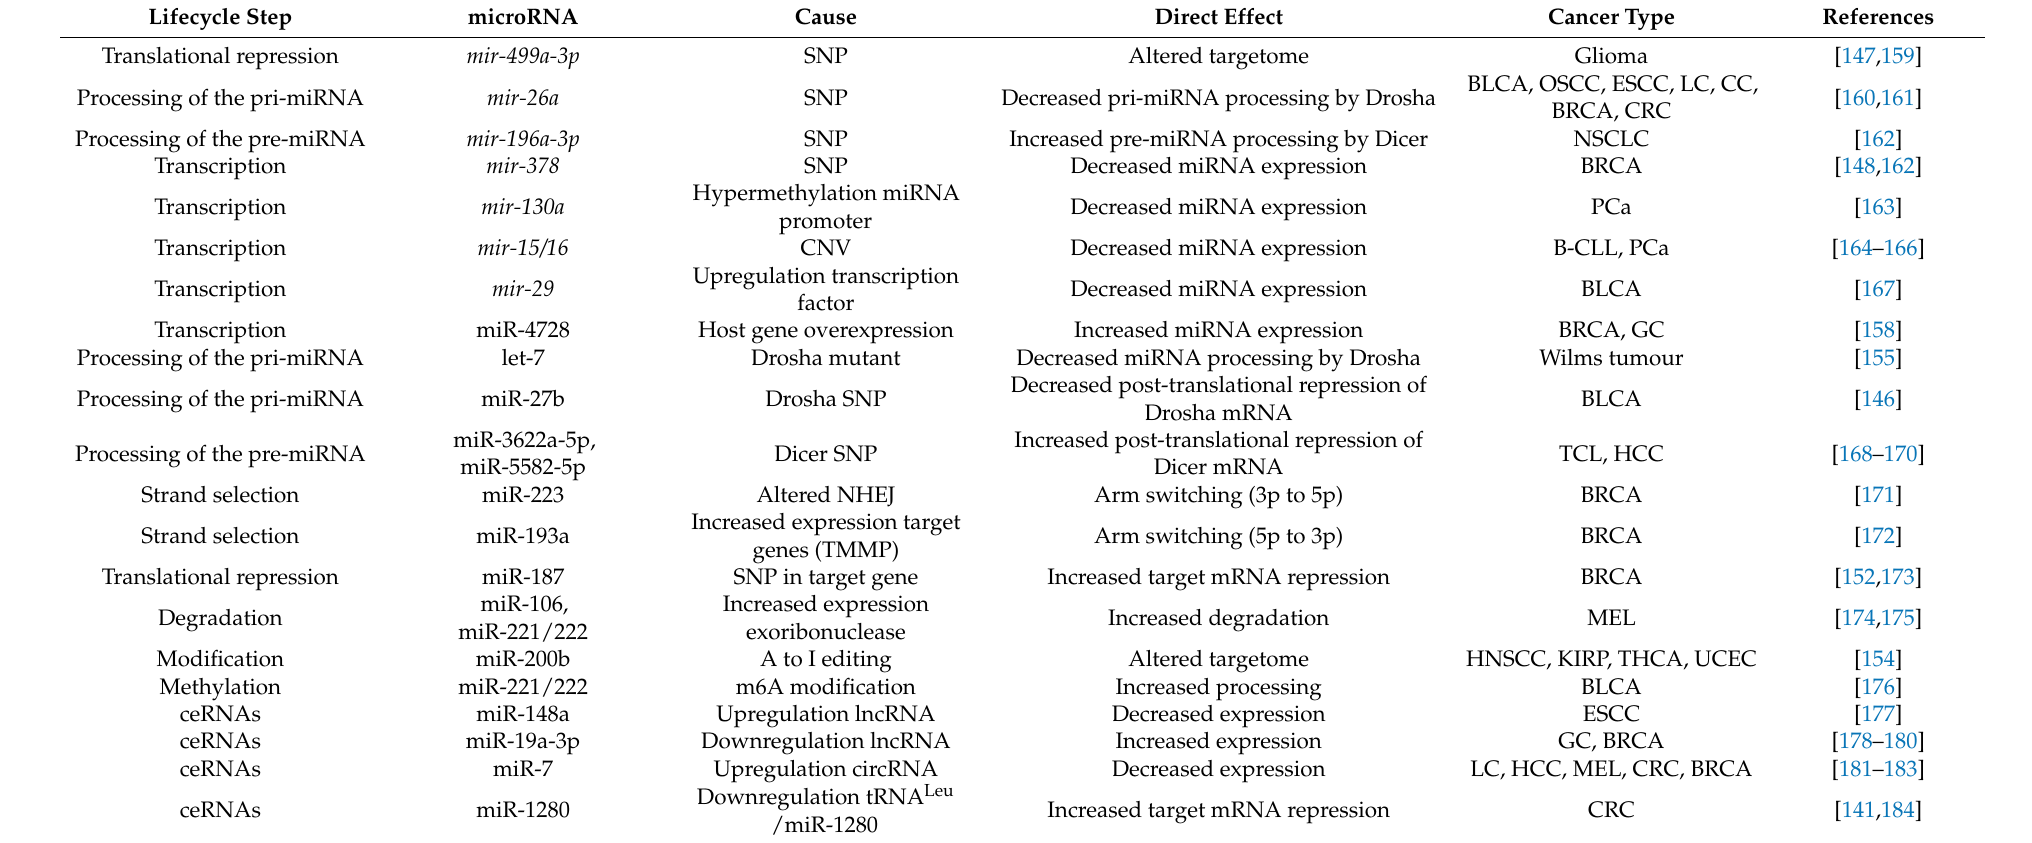
Table 1. Examples of dysregulated microRNAs in cancer. The first column indicates the step within the microRNA (miRNA) lifecycle that is altered, based on the chapters in this review. The second column includes the name of the miRNA(s) that have been altered. The third column describes the cause of the dysregulation, including genetic and post-translational changes. The fourth column explains the direct effect the miRNA alteration might have. The last column shows in what cancer type(s) this miRNA dysregulation has been identified, only including the types that have been described within this review. miRNA encoding genes are written in italics, while mature miRNAs are indicated with the capital letter R in